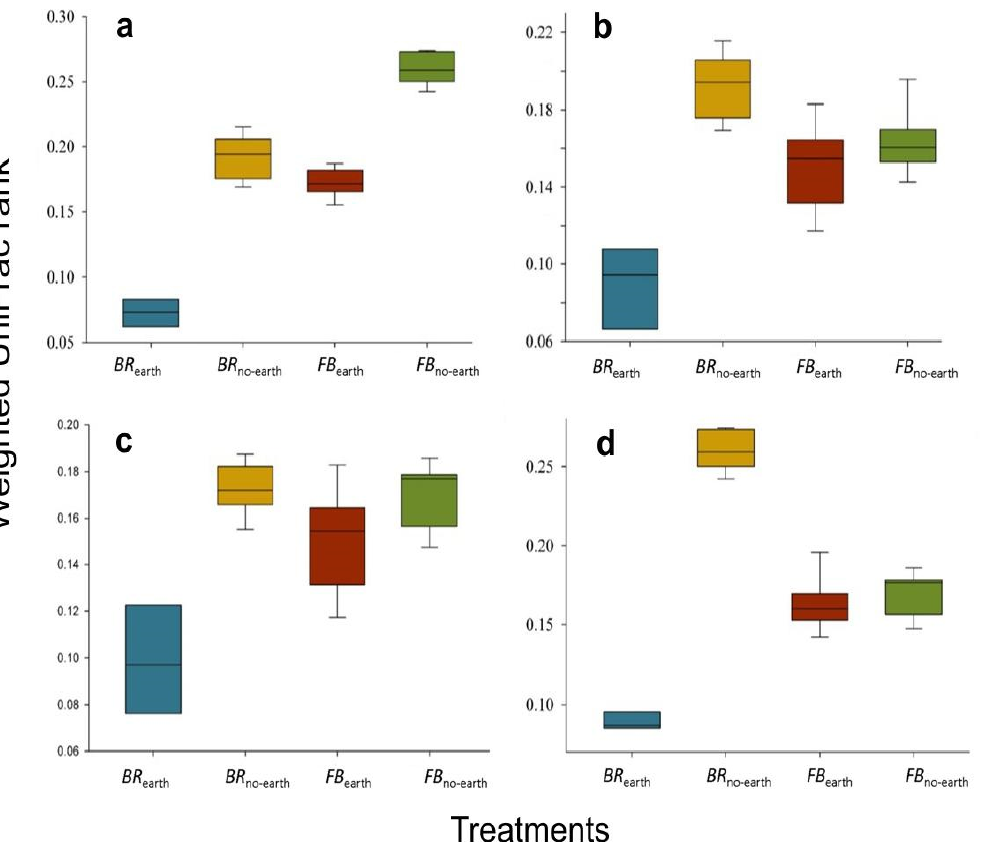
Figure 5. Distance of the group of treatments in ( a ) broccoli with earthworms ( BR earth ), ( b ) broccoli without earthworms ( BR no-earth ), ( c ) faba bean with earthworms ( FB earth ), and ( d ) faba bean without earthworms ( FB no-earth ) based on the analysis of similarities (ANOSIM). The estimated R value (=0.99) proved dissimilarity between groups ( p < 0.001). The measures within each treatment are in triplicate.